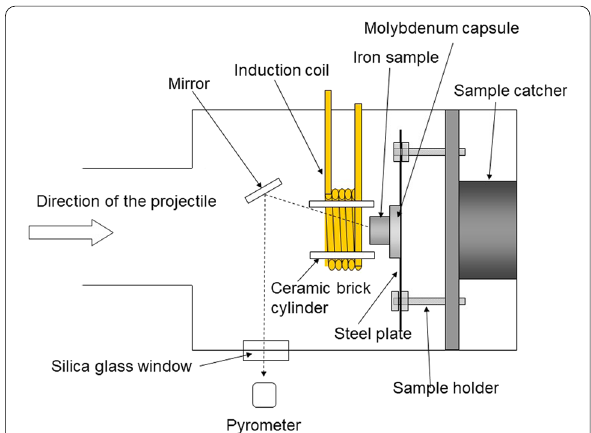
Fig. 2 A schematic image of the sample chamber with the heating and temperature measuring systems used for the two-stage light gas